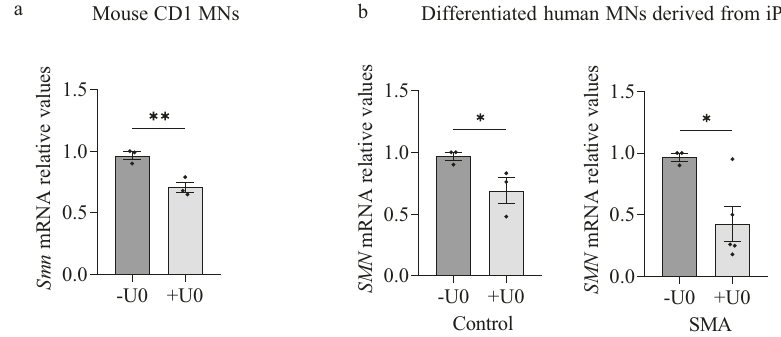
Fig. 3 ERK MAPK pathway regulate SMN mRNA levels in MNs. Total RNA was extracted from 20 μ M U0126-treated ( + U0) or non-treated (-U0) ( a ) 6-day cultured CD1 MNs or ( b ) 7-day differentiated Control and SMA human MNs. RNA was reverse transcribed to cDNA. Smn ( a ) and SMN ( b ) were ampli fi ed through RT-qPCR. Gapdh ( a ) and GAPDH ( b ) were used as control. Graph values are the mean of Smn ( a ) and SMN ( b ) gene expression from 3 independent differentiation cycles ± SEM. Asterisks indicate signi fi cant differences using Student t test (* p < 0.05; ** p <